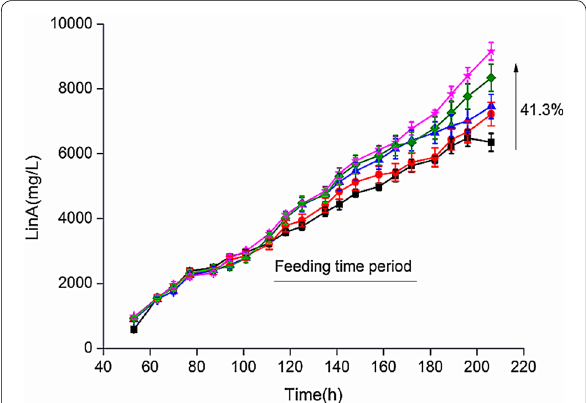
Fig. 2 Time course of LinA production with various feeding modes. Filled square: control, filled circle: mode 6, filled triangle: mode 7, filled star: mode 8, filled diamond : mode 9. Each point represents the mean ( n 3) standard = ±